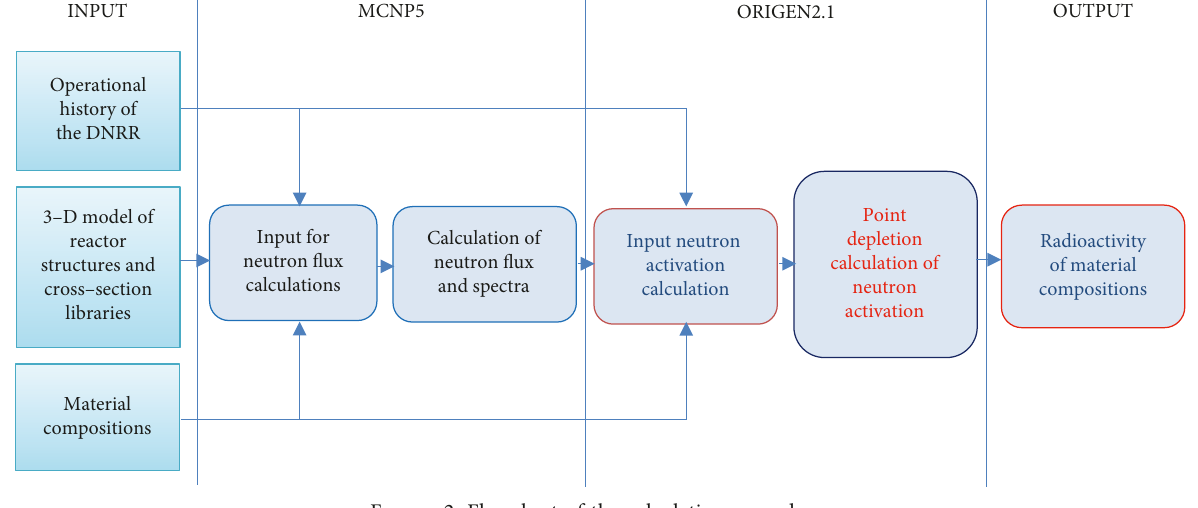
Figure 2: Flowchart of the calculation procedure.